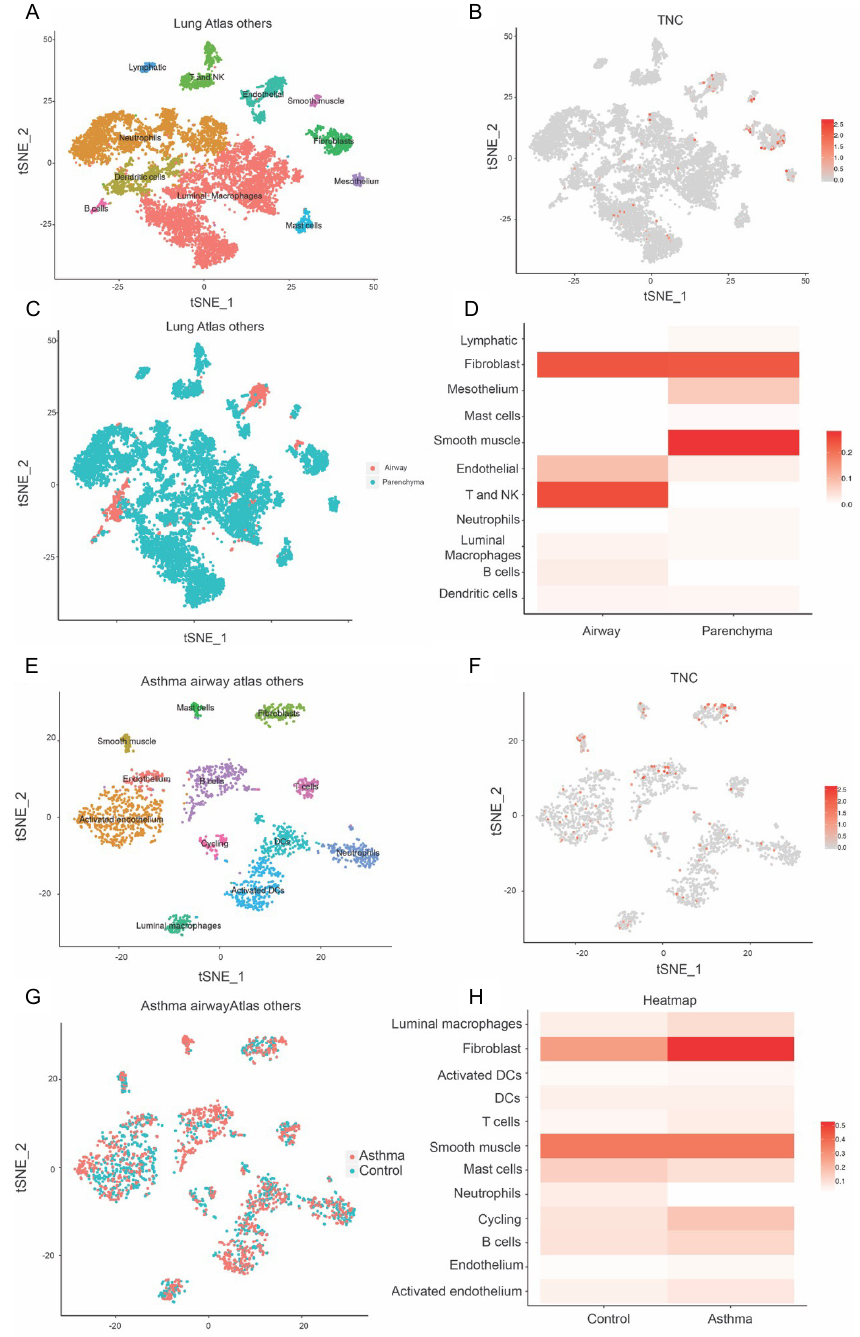
patients. ( F ) TNC distribution in different epithelial cells in asthmatic patients. ( G ) Epithelial cell distribution in asthmatic and control patients. ( H ) TNC distribution in control and asthmatic pa- tients .